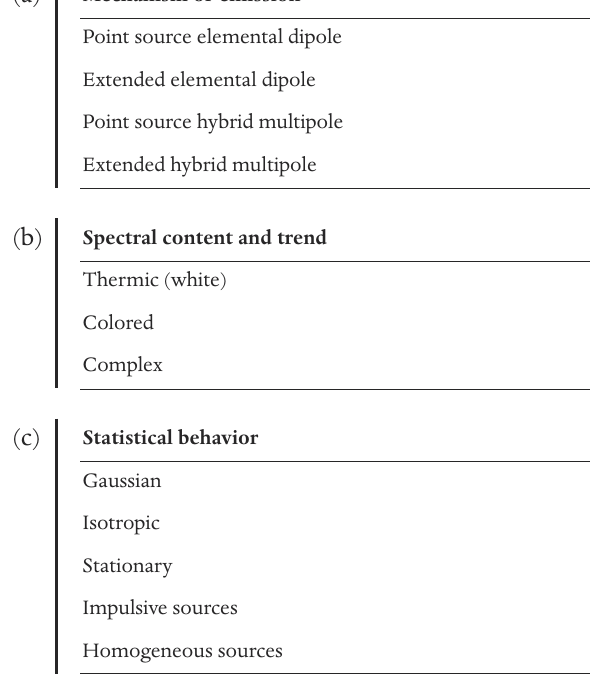
Table 4. Some expected features of the EM wave internal